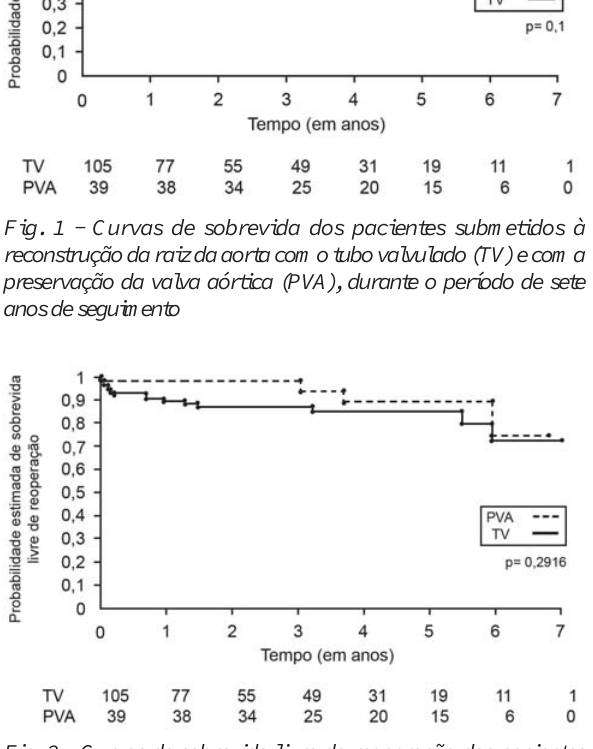
Fig. 2 - Curvas de sobrevida livre de reoperação dos pacientes submetidos à reconstrução da raiz da aorta com o tubo valvulado (TV) e com a preservação da valva aórtica (PVA), durante o